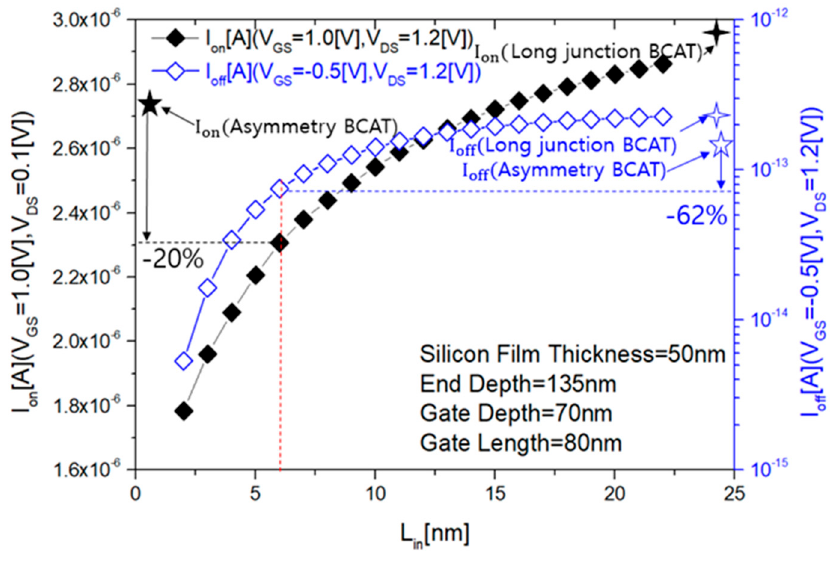
Figure 12. Change of I on and I off according to L in in Pi-BCAT at a gate depth = 70 nm.